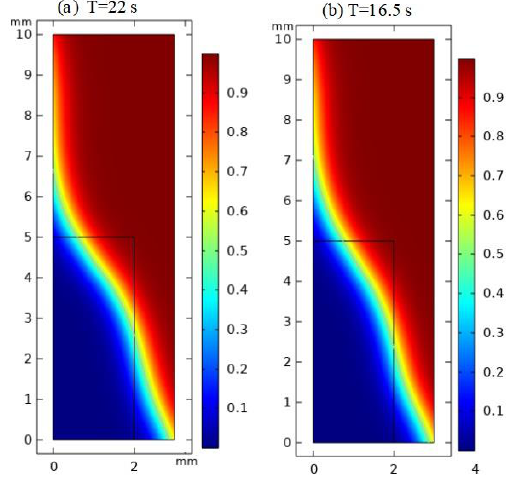
Figure 5. Simulation results of adhesion of hot-melt glass on SiO 2 and Au substrates: ( a ) SiO 2 ; ( b ) Au.